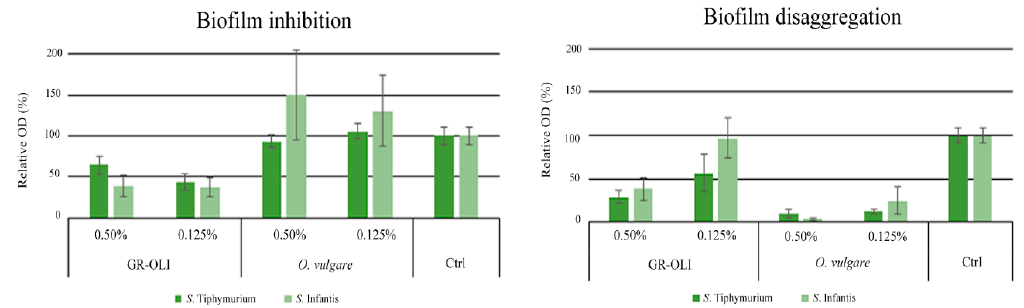
Figure 1. Control-related ratios of the OD values measured for S. Typhimurium and S. Infantis biofilm inhibition and biofilm disaggregation by GR-OLI and O. vulgare EO. Vertical bars indicate ± standard errors.